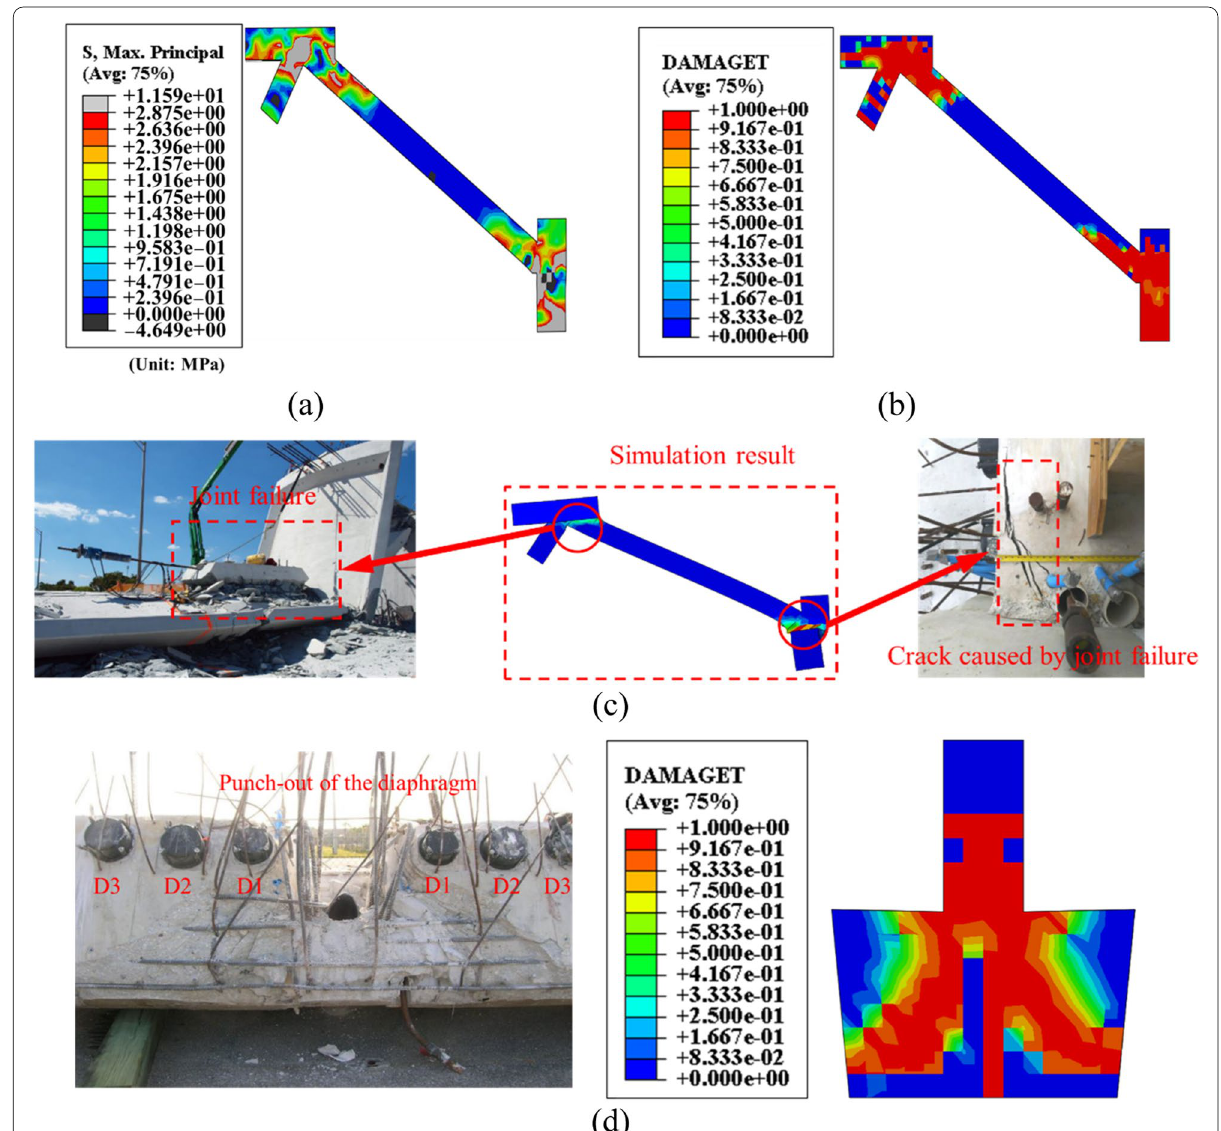
Fig. 10 Analysis results of member 11: a contour of the maximum principal stress before the re-tensioning of member 11 (unit: MPa); b contour of DAMAGET before the re-tensioning of member 11; c failure mode of the bridge after the re-tensioning of member 11; and d tensile damage of the diaphragm after re-tensioning of member